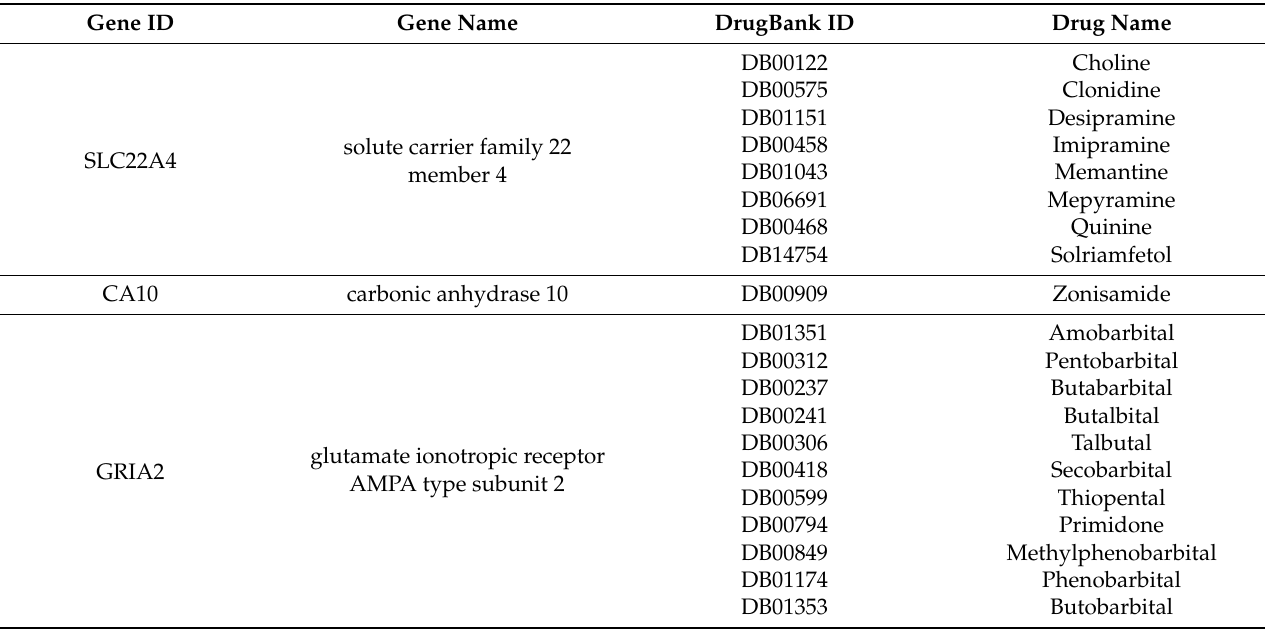
Table 2. Approved drugs targeting identified neighboring genes adjacent to differentially expressed HERV elements for brain-related